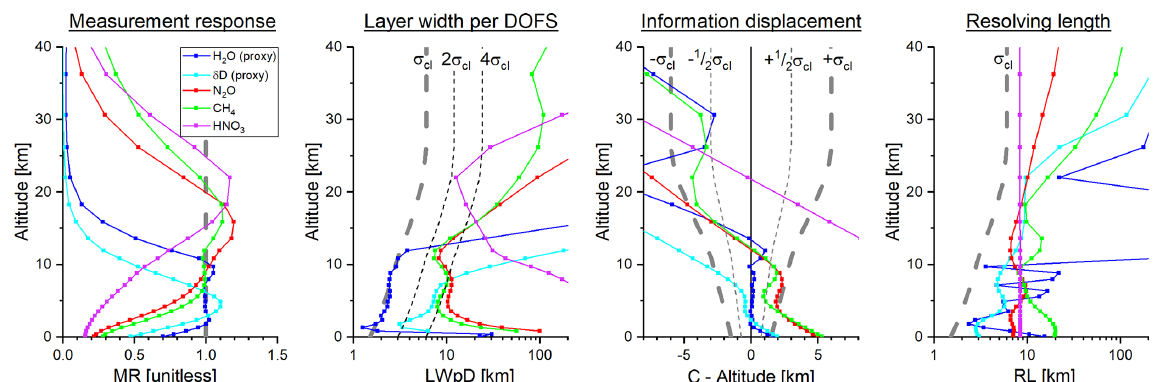
Figure 11. Profiles with averaging kernel metrics for the 30 August 2008 example observation over Lindenberg used for Fig. 9. For orienta- tion the thick dashed grey lines indicate the 100% value (for the panel showing the measurement response) and the a priori assumed vertical correlation length (for the panels showing the layer width per DOFS, information displacement, and resolving